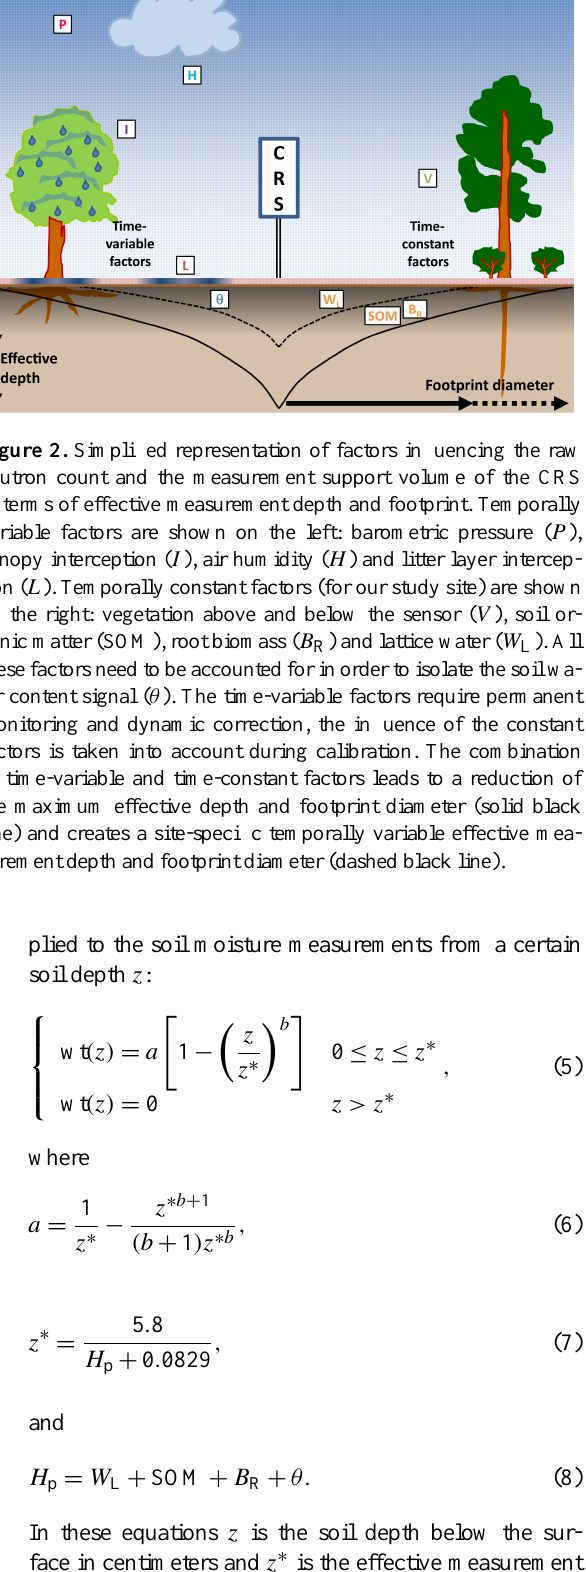
Table 2. Overview of the four weighting approaches for other than soil moisture effects on the CRS signal.